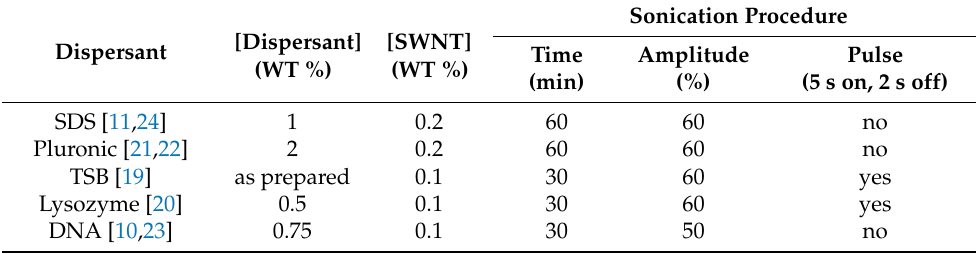
Table 3. Initial concentrations and sonication protocols from each dispersion based on the